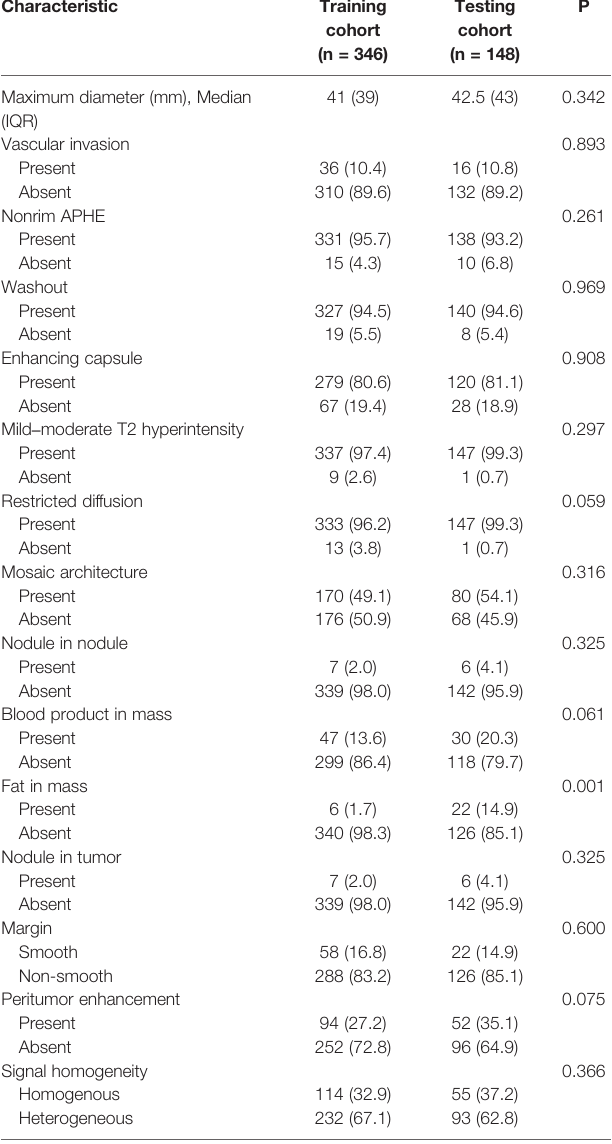
TABLE 2 | Factors associated with overall survival after curative resection according to multivariate analysis in the training cohort.